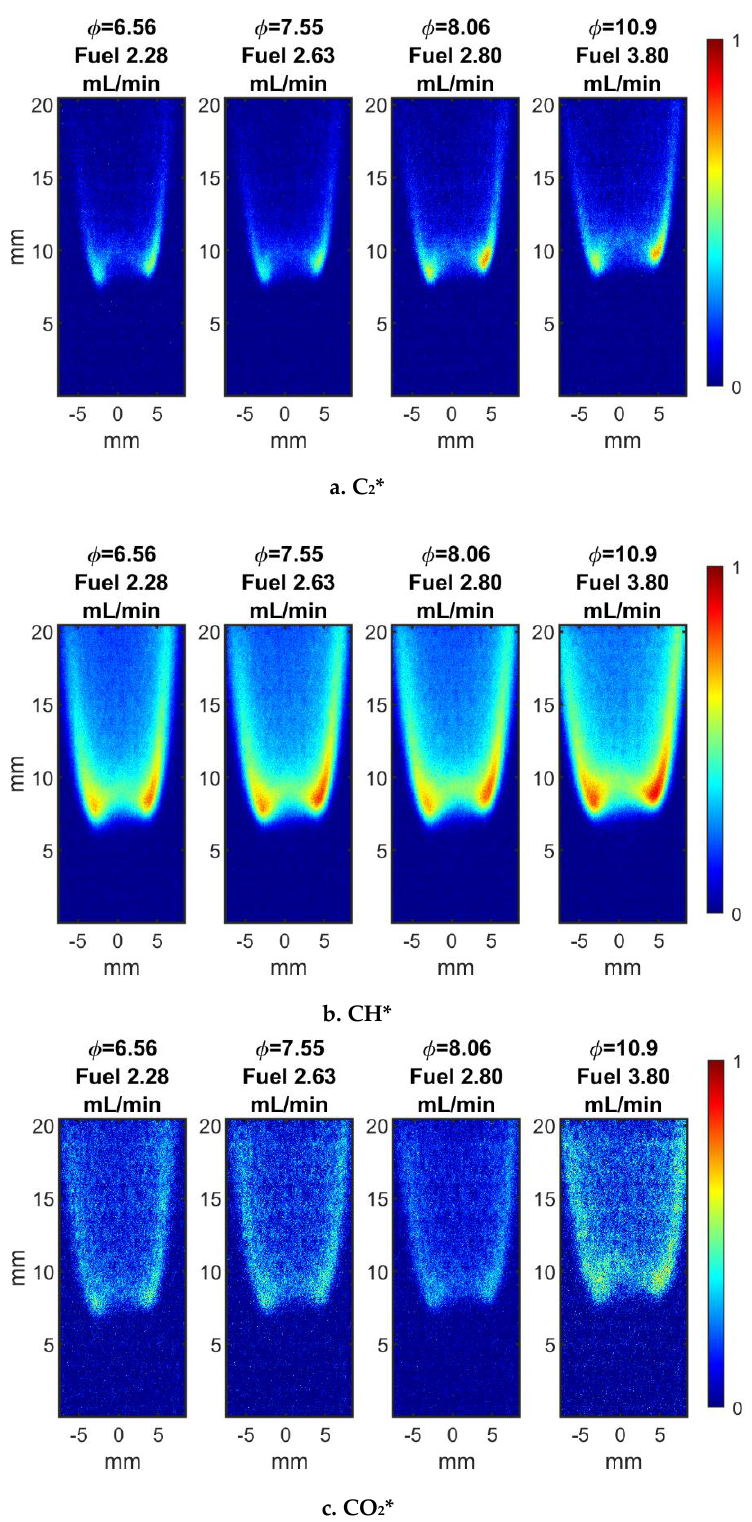
Figure 10. C 2 * ( a ), CH* ( b ), and CO 2 * ( c ) emissions for ignited ethanol sprays. The O 2 flow rate was fixed at 0.4 L/min.